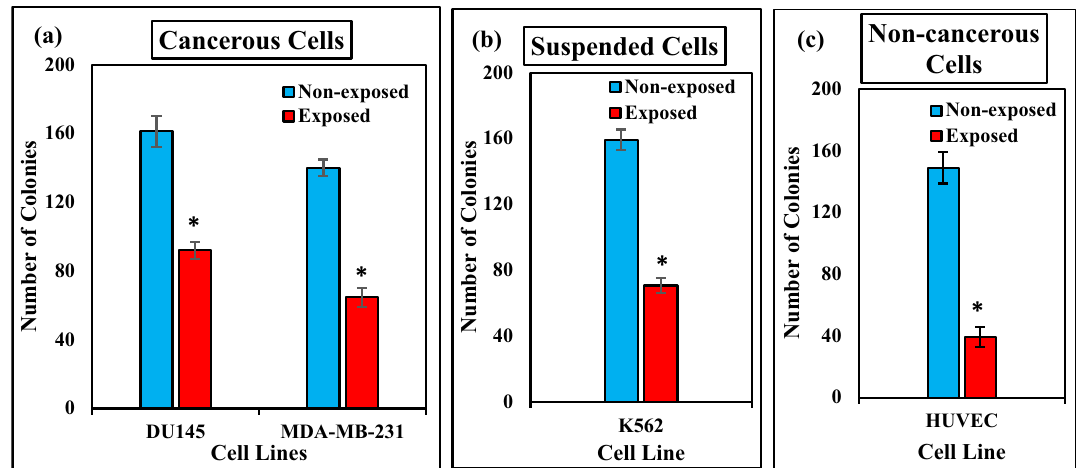
Figure 8. ELF-EMF decreases Clonogenic ability. Plot showing the colony formation of the non-exposed and exposed cells in intensity 100 mT for ( a ) cancerous cells (DU145 (0.01 Hz), MDA-MB-231 (1 Hz)), ( b ) non- cancerous cells (HUVEC) frequency 0.01 Hz, ( c ) suspended cells (K562) frequency 0.01 Hz for 120 h of ELF- EMF exposure. Bars indicate means ± SEM obtained from three or more independent experiments. Statistical significance between non-exposed and exposed groups was evaluated by a t-test. ( P -value < 0.05) was considered to indicate statistical